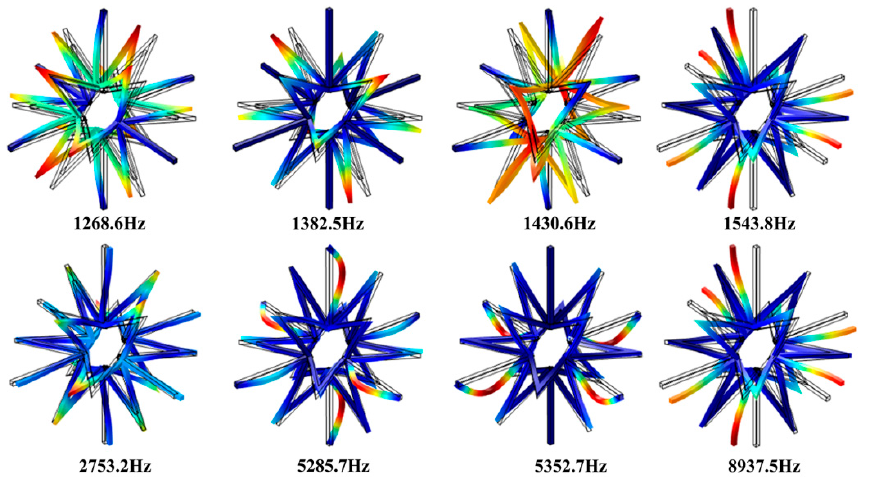
Figure 5. Vibration modes at the band gap cut-off frequencies of the 3D star structure.